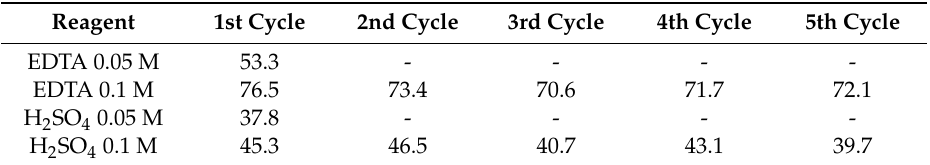
Table 4. Desorption e ffi ciency (%) for each adsorption cycle.